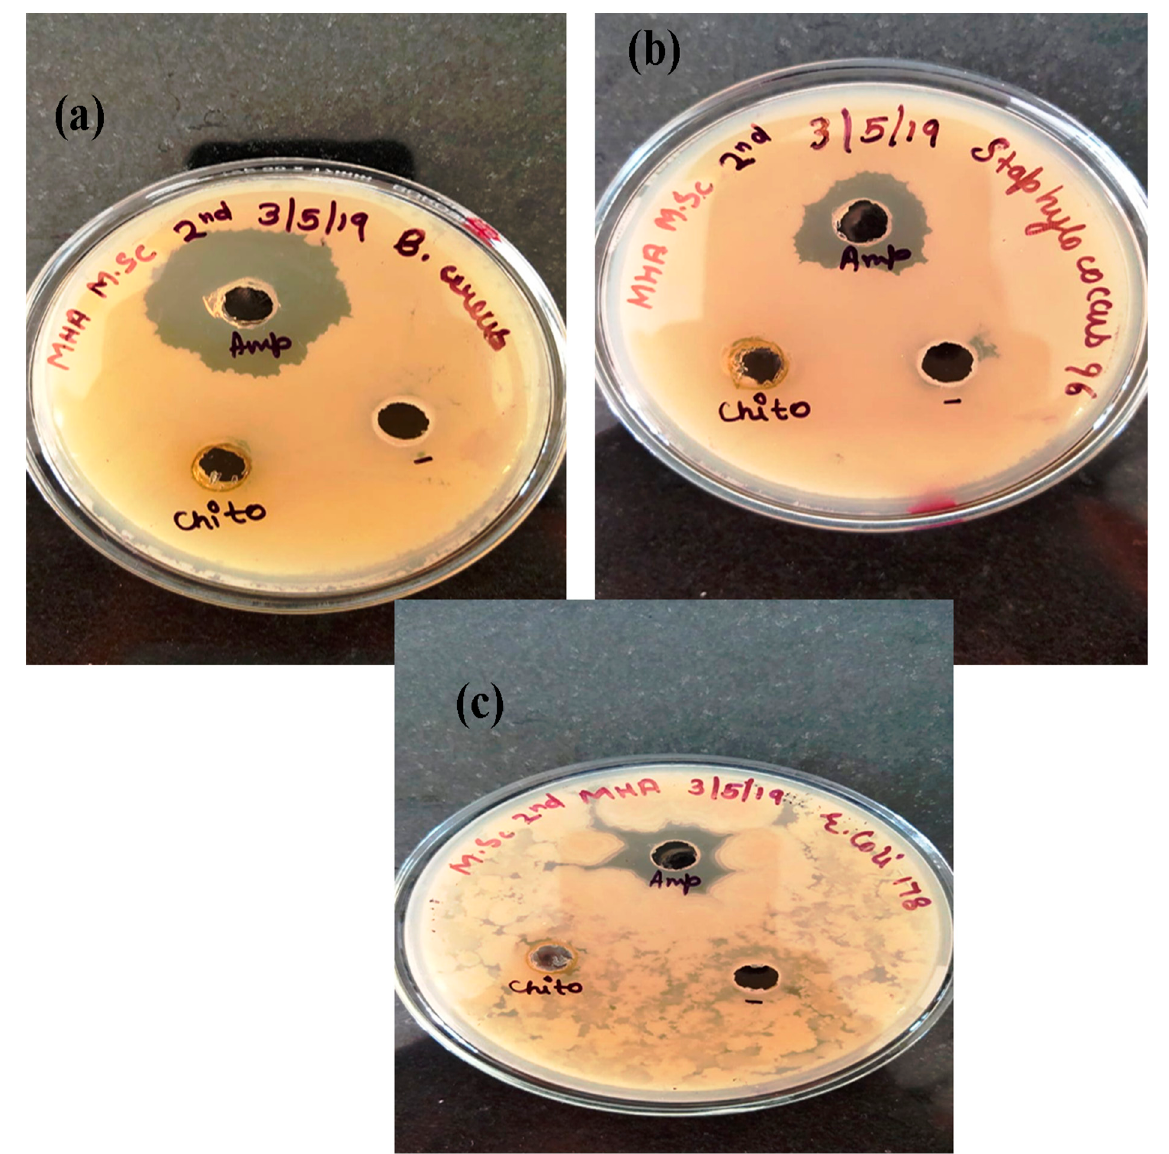
Figure 10. Antibacterial activity of NPs and CH-Ag bionanocomposite against ( a ) Bacillus cereus , ( b ) Staphylococcus , and ( c ) Escherichia coli by agar well diffusion method.